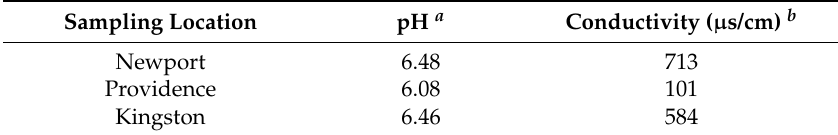
Table 1. pH and conductivity data for sampling locations.